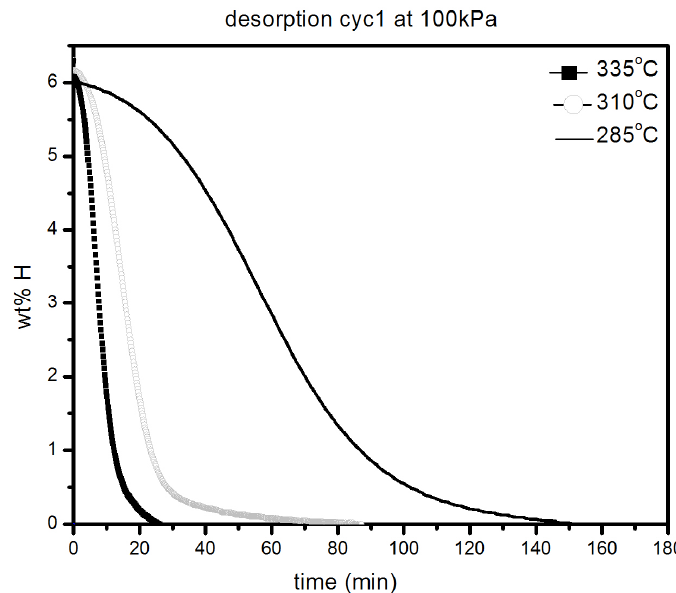
Figure 8. Desorption under 100 kPa H 2 at different temperatures of 1 h milled MgH 2 + 5 mol % MgF 2 .